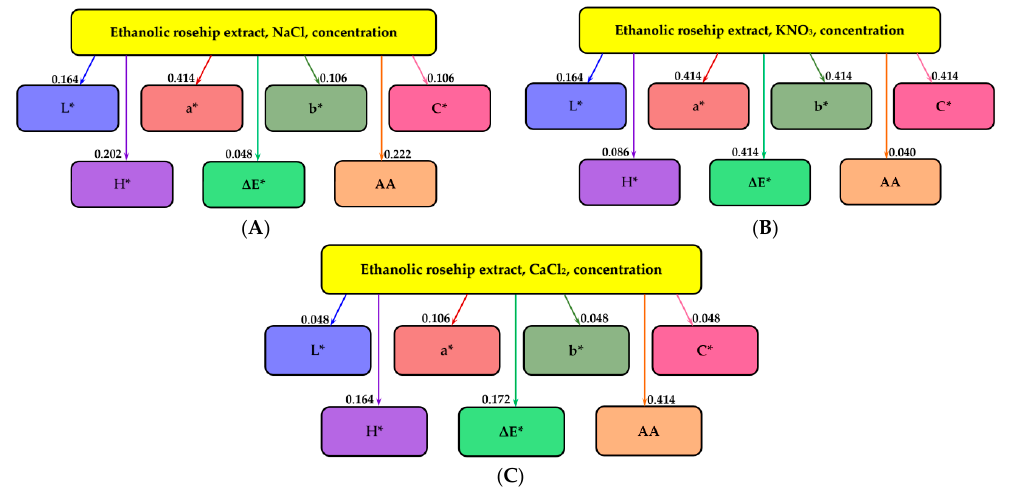
Figure 2. The influences of NaCl ( A ), KNO 3 ( B ) and CaCl 2 ( C ) on the CIELab color parameters and the antioxidant activity of rose hip extract. L*—luminosity; a*—red/green component; b*—yellow/blue component; C*—chromaticity; H*—hue angle; Δ E*—overall difference of color; AA—antioxidant activity.